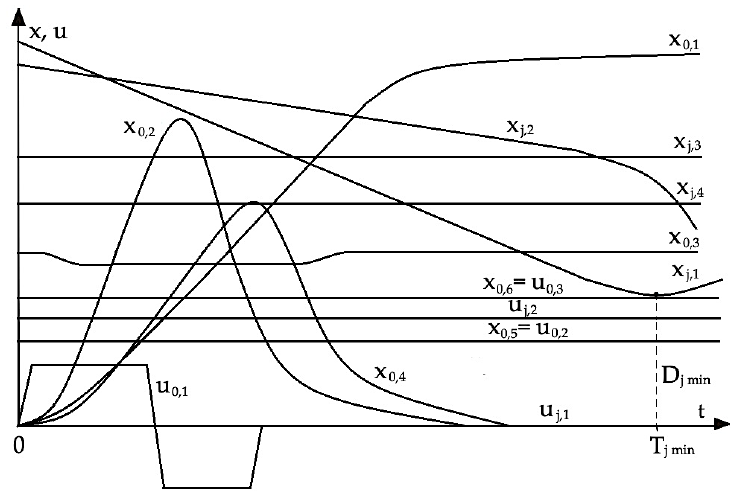
Figure 4. Runs of state and control variables of the differential game model during the anti-collision maneuver of changing the course of own object.